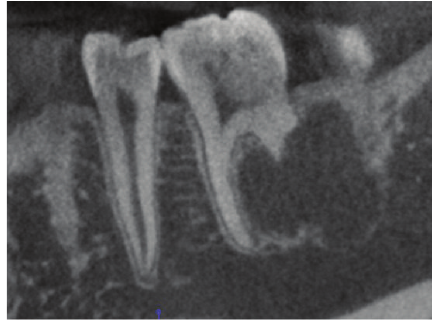
Figure 2: Panoramic radiograph demonstrating unilocular radiolu- cency with erosion of the distal root of tooth #19.